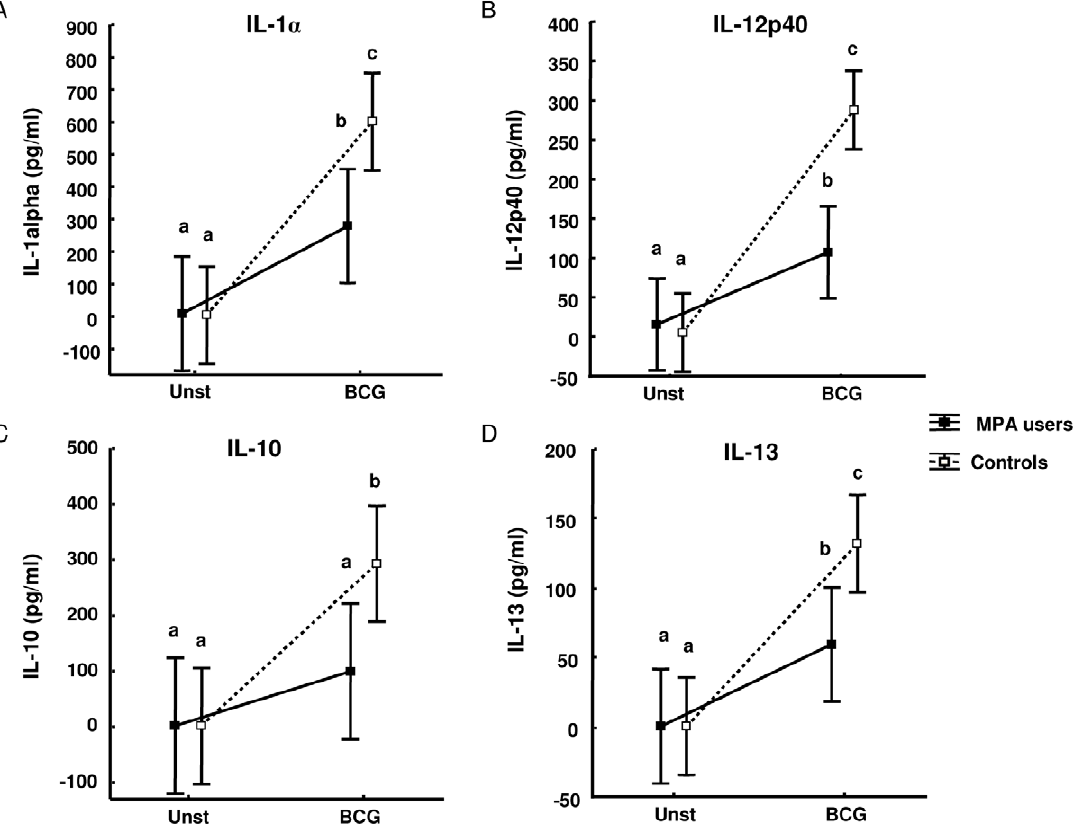
Figure 5. Differential expression of IL-1 a , IL-12p40, IL-10 and IL-13 in supernatants of BCG stimulated PBMCs of MPA users and control participants. PBMCs of MPA users (n=8) and controls (n=11) were cultured as unstimulated controls and with M.bovis BCG. Culture supernatants were collected after three days and cytokine responses were measured by Multiplex bead array assay. Data were analyzed by mixed model repeated measures ANOVA with a Fisher LSD Post-Hoc test and are represented as LS means and 95%CI. The letter a, b and c indicate statistical significance. Values with the same letters are not statistically significantly different from each other. doi:10.1371/journal.pone.0024639.g005 PLoS ONE |